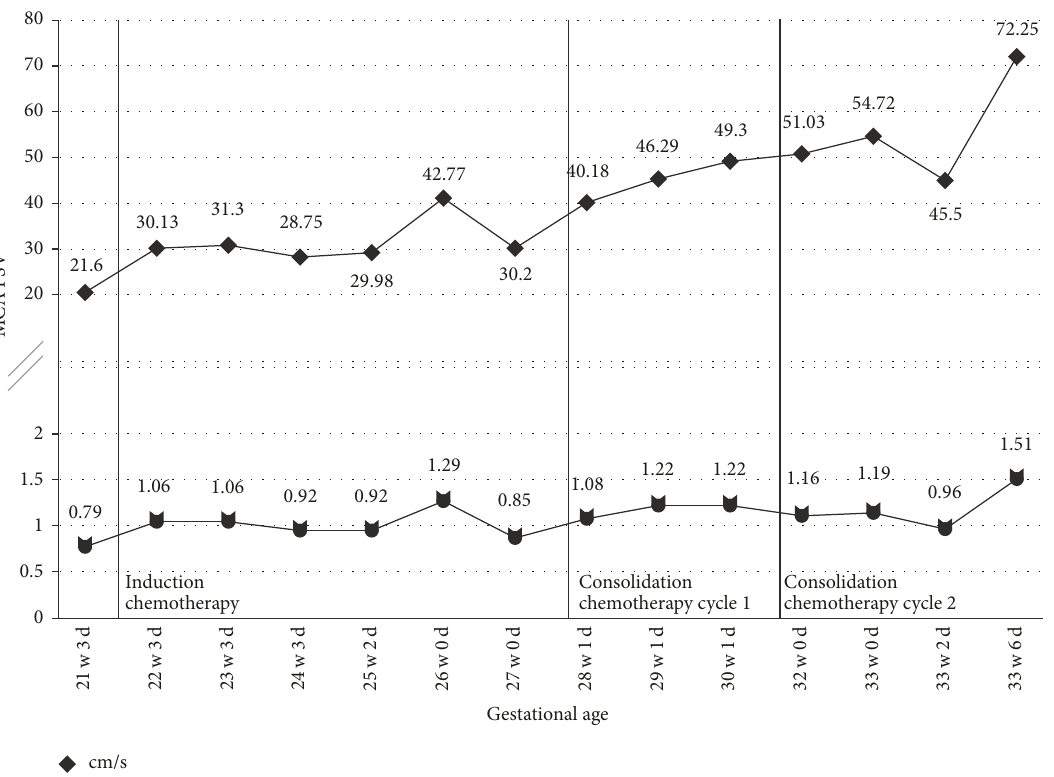
with a positive platelet antibody and required HLA-matched platelets; thus, she remained inpatient until count